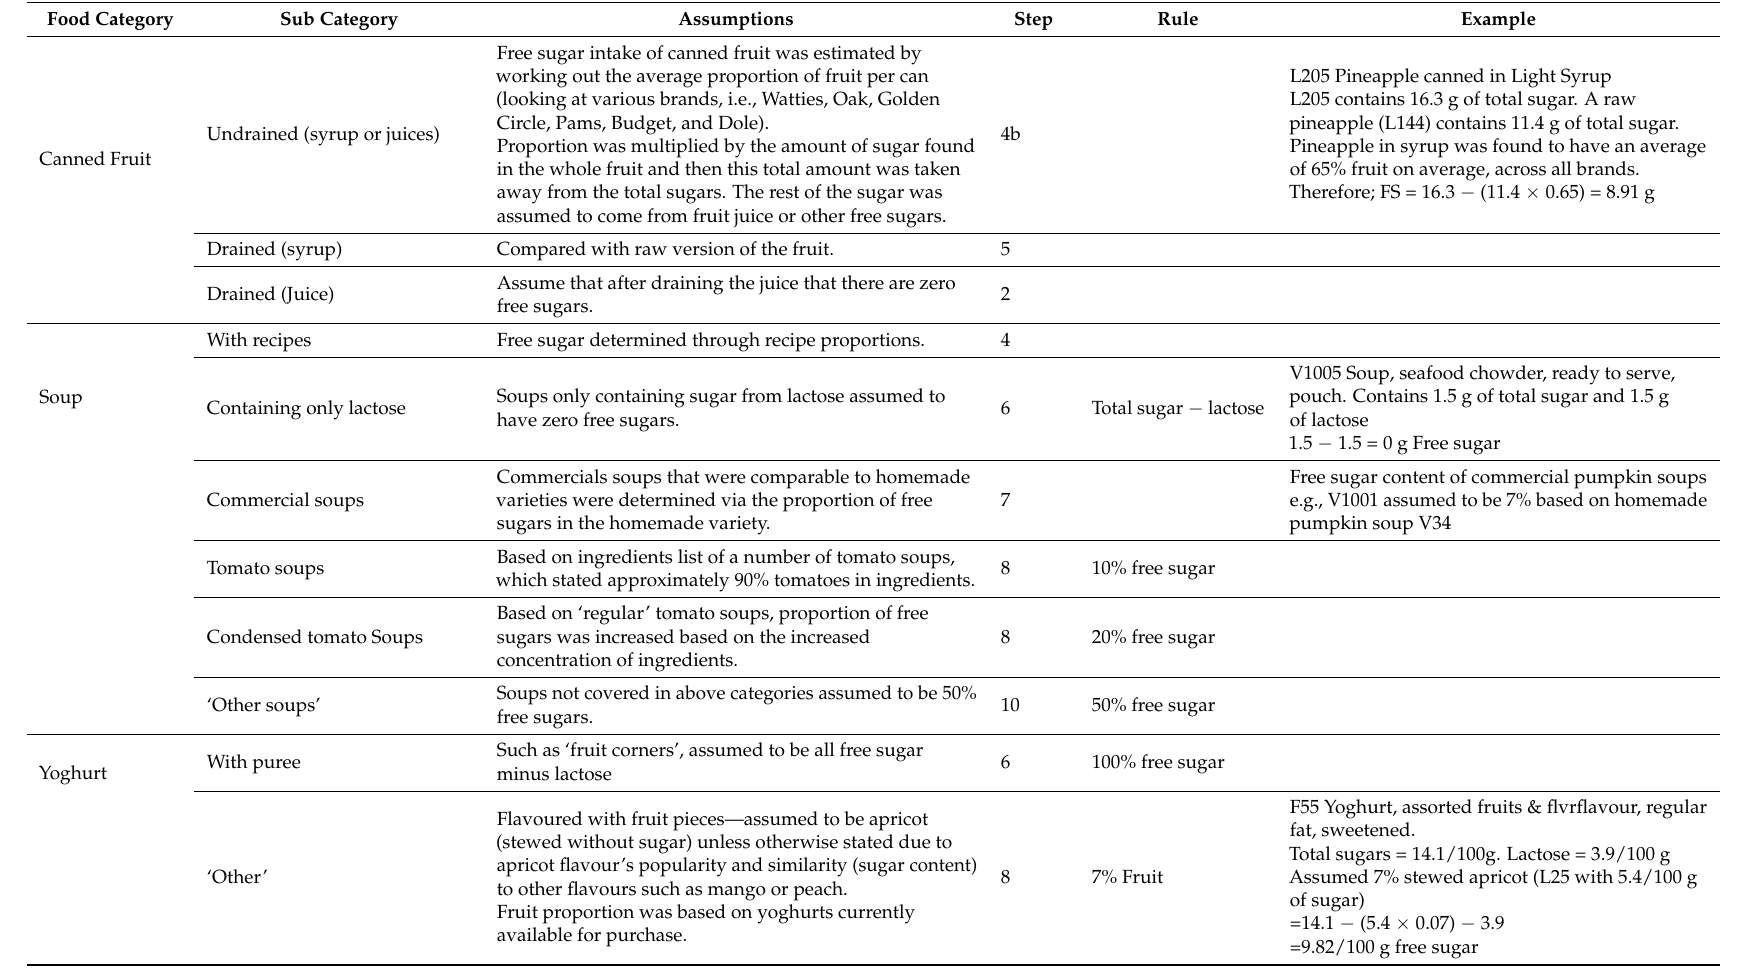
Table A1. Additional